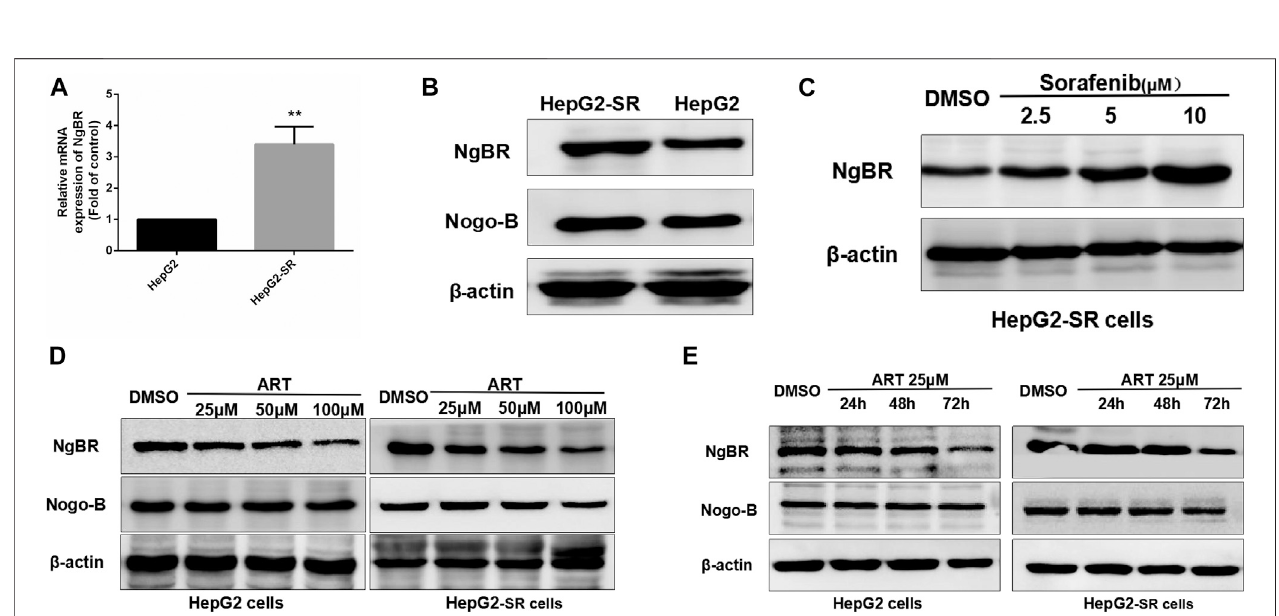
FIGURE 2 | Artesunate (ART) can inhibit NgBR expression in sorafenib-resistant HCC cells. NgBR expression was higher in HepG2-SR cells as determined by (A) qRT-PCRand (B) westernblotting.Westernblotting (C) indicatedthatNgBRexpression increasedinadose-dependentmannerinthepresenceofsorafenibinHepG2- SR cells. The experiment was performed in triplicate. Western blotting indicated that artesunate can inhibit the expression of NgBR in both HepG2 cells and sorafenib- resistant HCC cells, in a dose-dependent manner (D) and in a time-dependent manner (E) . Experiments were repeated three times, and data are expressed as means ± the standard error of the mean. Student ’ s t -test was used to analyze the data. * p < 0.05